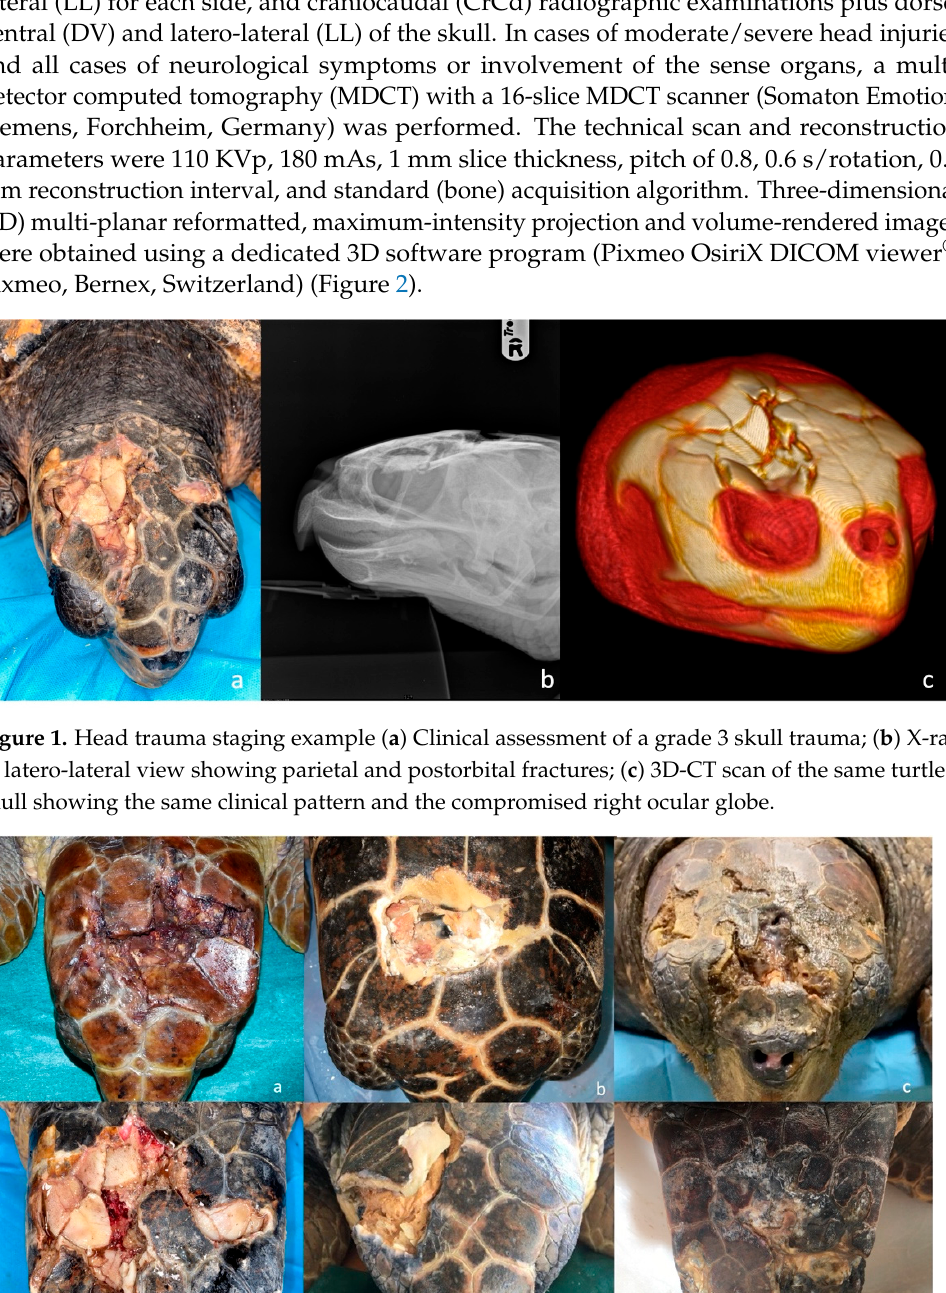
Figure 2. Examples of Caretta caretta with head trauma arrived at STC . ( a ) Acute trauma of parietal and frontal bone with hemorrhage; ( b ) chronic trauma of parietal bone with exposure of the underlying soft tissues; ( c ) chronic trauma of frontal, nasal bone and right postorbital bones; ( d ) acute trauma of left parietal, frontal, postorbital bones with oozing of serum and hemorrhage; ( e ) chronic trauma of right postorbital and parietal bones with the presence of fibrotic tissue; ( f ) chronic trauma of left frontal bone and parietal